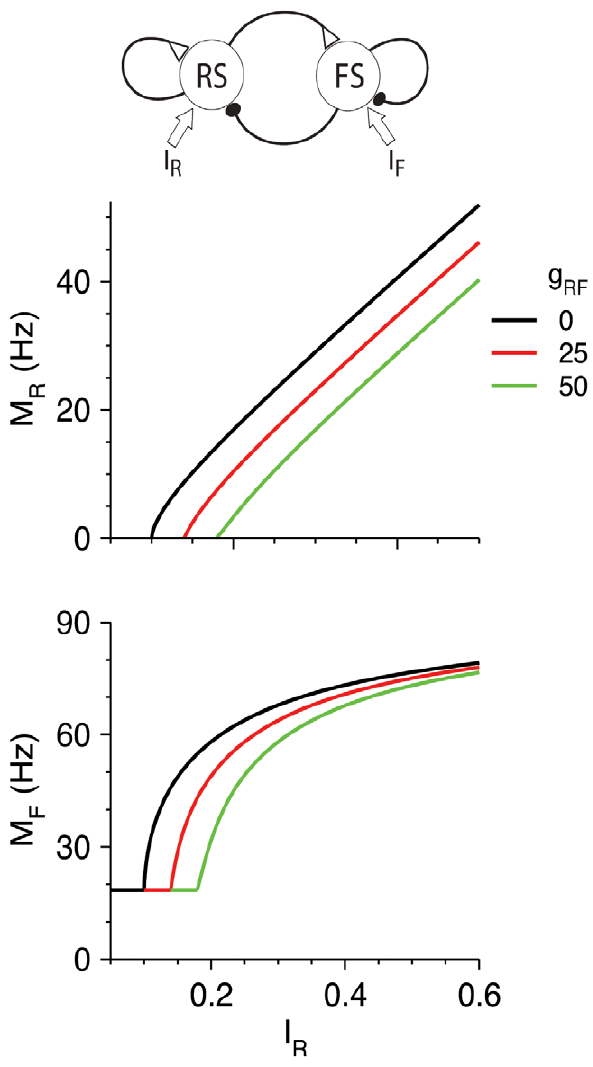
Figure 6. Response of the RS-LTS circuits to absence-seizures input from the thalamus. Additional parameters are g RL =35, g LR =7.5, g RR =0. (A) Response of the circuit to a periodic square input to the RS neurons, mimicking thalamic input during an absence-seizure state (bottom panel). Time courses of M R (top panel) and M L (middle panel) are plotted for I R with amplitude 3.5 and duty cycle of 0.1 (i.e., , I R . =0.35). The right top and middle panels depict the time course of